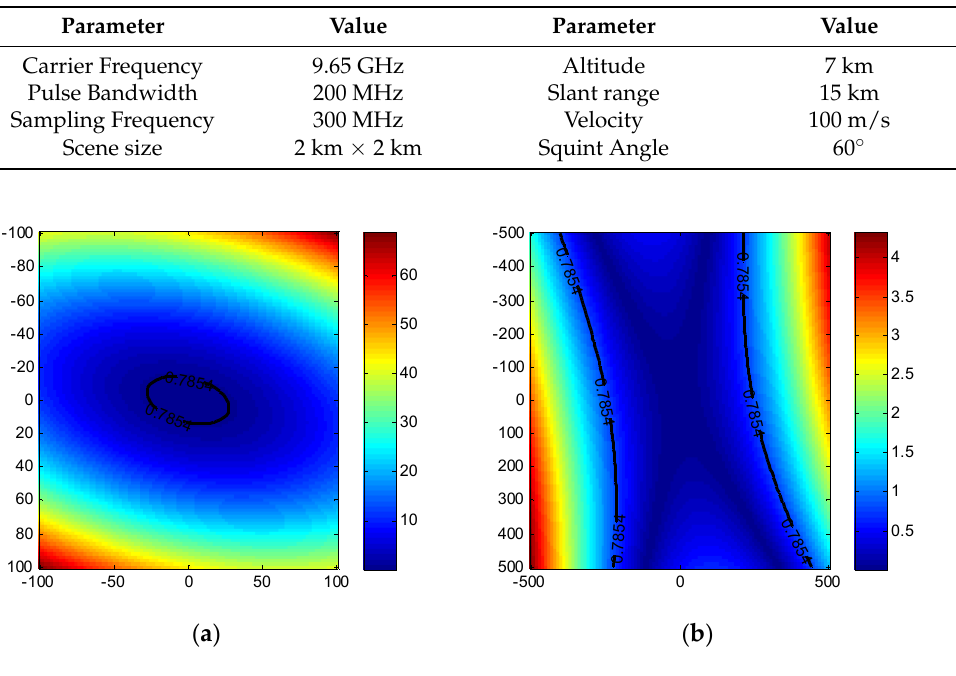
( b ) Figure 3. Phase errors caused by the approximation of the curvature range error: ( a ) In range–azi- muth plane; ( b ) in the height–azimuth plane. 3. Imaging Approach The linear frequency modulation (LFM) signal is assumed to be the transmitted sig- nal. We transform the signal to the range frequency domain and perform range compres- sion. Then the echo signal is given by: (